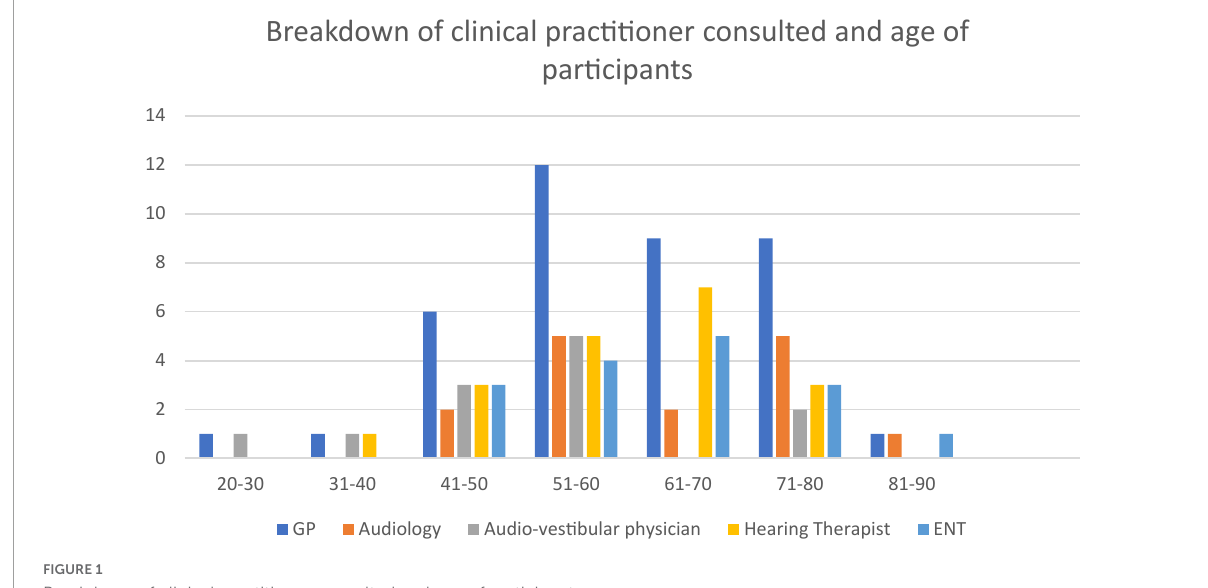
FIGURE1 Breakdown of clinical practitioner consulted and age of participants.